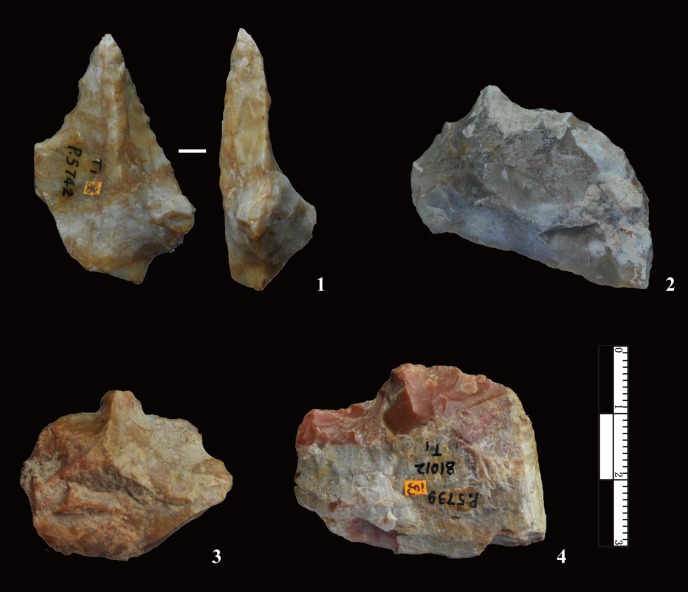
Point and borers from DGT.No.1: point with retouch on ventral and dorsal faces and along two edges on both sides to form a tip. The retouch is systematic and the length on the two converging edges are 18.7 mm and 31.1 mm respectively; No. 2–4: borers displaying retouch to form short and rounded tips.